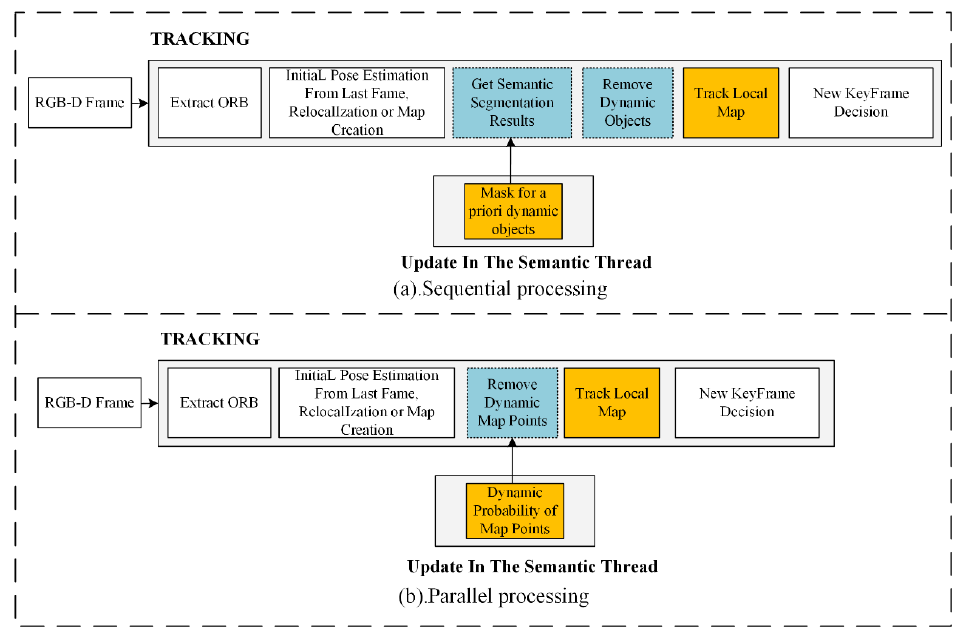
Figure 3. Comparison of sequential and parallel processing